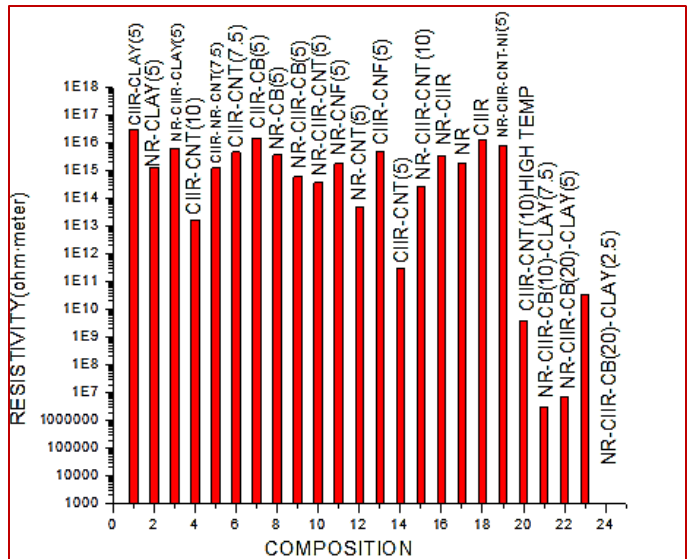
Figure 8. Resistivity – composition graph of hybrid filler composition and blend rubber nanocomposite in NR/CIIR matrix.